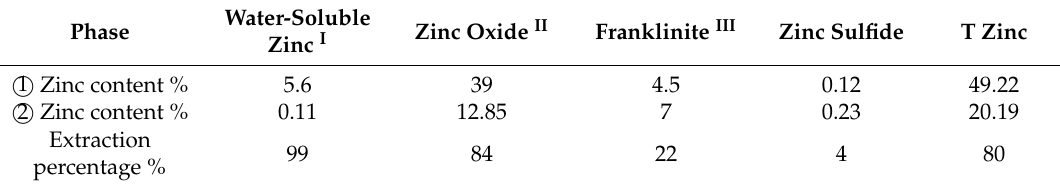
Table 2. Mineralogical composition of C.Z.O.